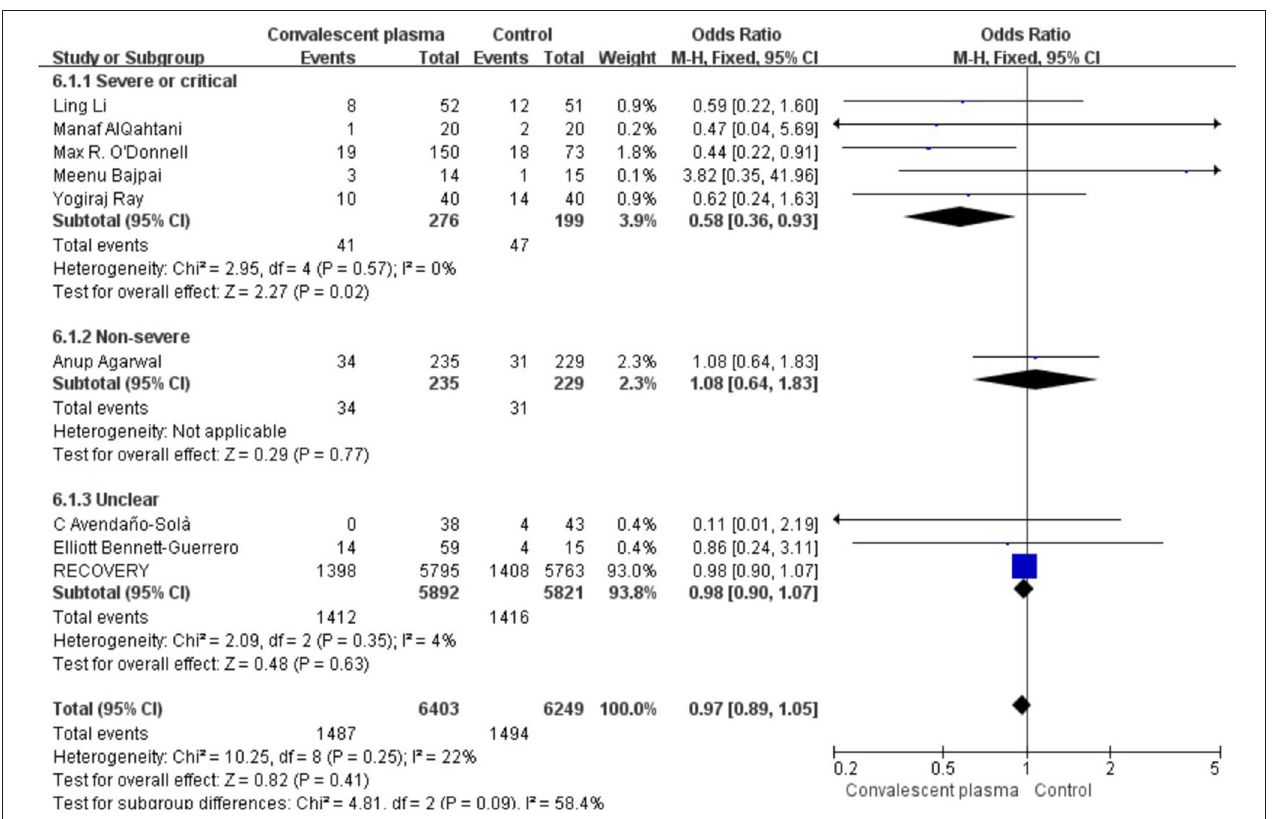
FIGURE 5 | Sub-analysis of pooled odds ratios (ORs) in mortality of 28-days according to severity. Weights are from fixed-effects analysis. CI, confidence interval.